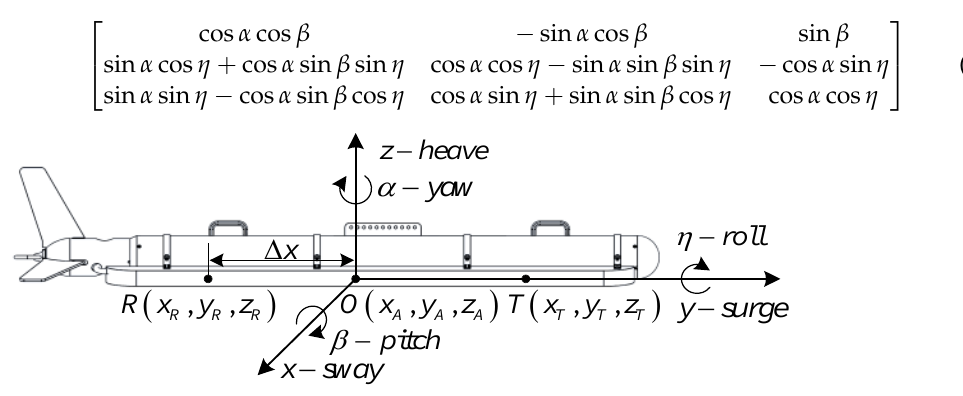
Figure 4. Self − coordinate system of the sonar platform. Figure 4. Self–coordinate system of the sonar platform.